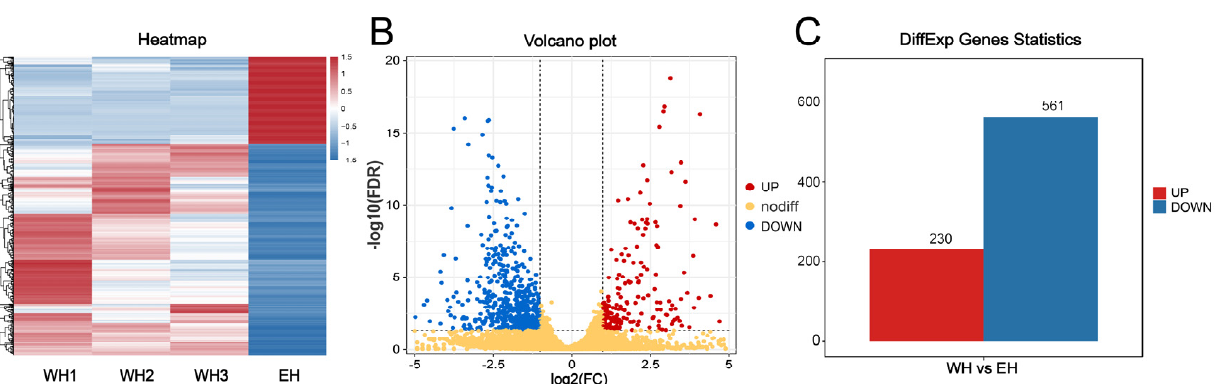
Figure 5. Sample gene expression. ( A ) Sample Correlation Heat Map. ( B ) Volcano plot of WH and EH differentially expressed genes. ( C ) Histogram of WH and EH differentially expressed genes.